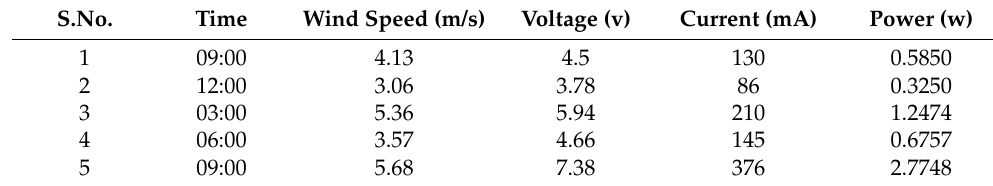
Table 3. Voltage and current measurement for a single turbine.